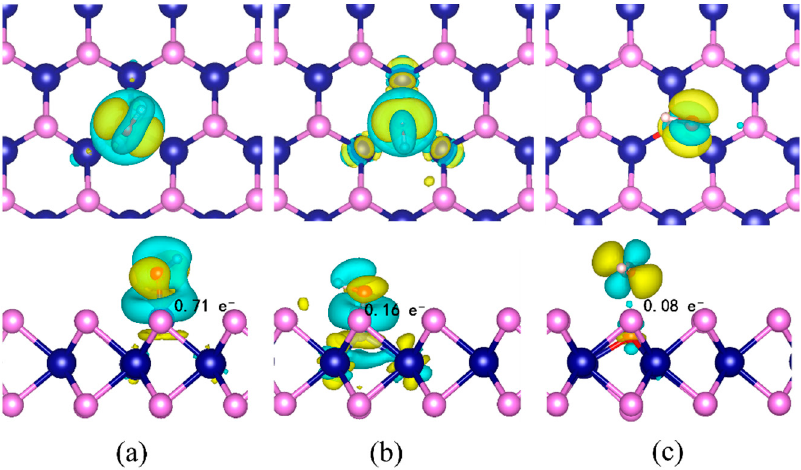
Figure 6. The charge difference density of OH * adsorption on ( a ) Si@CrS 2 N, ( b ) N@CrS 2 , and ( c ) O@CrS 2 with the isosurface of 0.003 e/Å 3 .Cyane and yellow bubbles represent positive and negative charges, respectively.